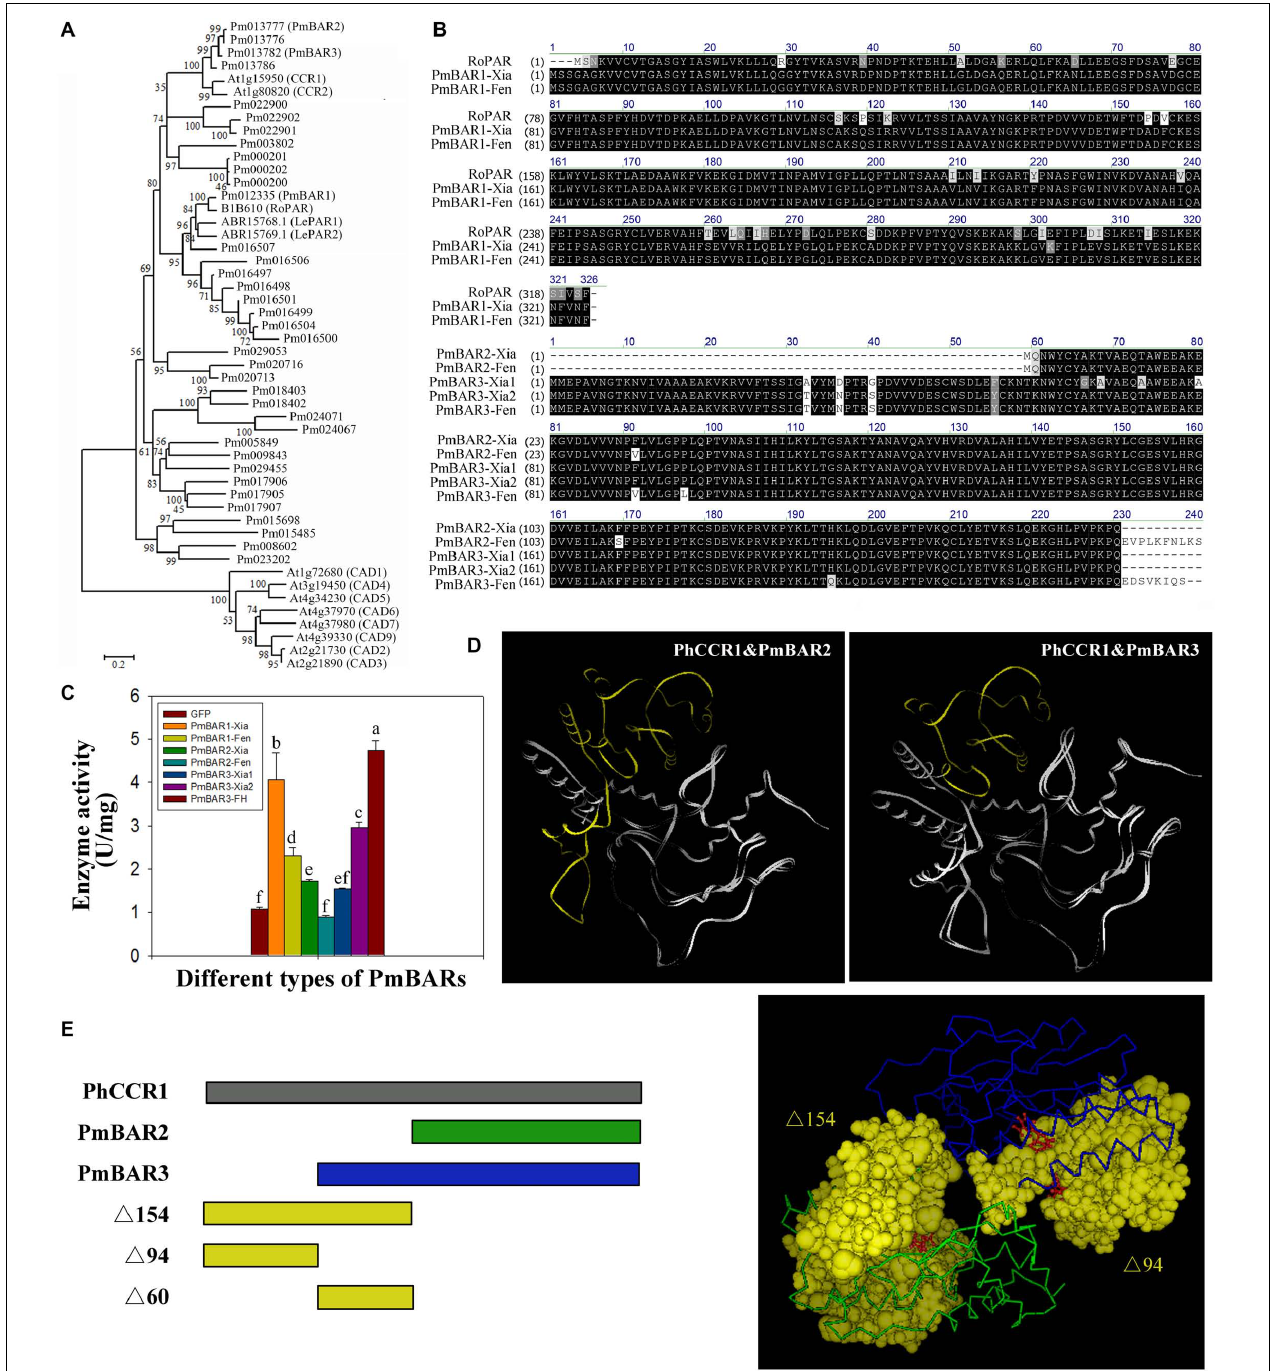
FIGURE 6 | Comparison of the sequences and enzyme activity of PmBARs from the different varieties. (A) Comparison of the PmBAR amino acid sequence in the “Xiangruibai” and “Fenghou” varieties. RoPAR, PAR in rose. RoPAR was used as a reference sequence to identify PmBARs in P. mume . (B) Phylogenetic tree of PmBARs, PARs, CCRs and CADs. The tree was generated using MEGA 6 software with the neighbor-joining method. The bootstrap values (%) are shown next to the branches. The branch lengths were determined by the evolutionary distance. (C) Enzyme activity of PmBARs from the “Xiangruibai” and “Fenghou” varieties. The data are presented as the mean values of three biological replicates ± SDs. The data are presented as the mean values of three replicates ± SDs. A sample expressing GFP was used as a negative control. (D) Comparison of protein tertiary structures between PhCCR1 and PmBARs. The underlying N-terminal deletion sequences PmBARs compared with PhCCR1 are marked in yellow. PhCCR1, CCR1 in petunia. (E) Model of NADP + binding to the N-terminus of PhCCR1 (PDB ID: 4R1S). Schematic diagram of the protein structures of PmBARs and PhCCR1 (left), in which different colors reflect the different segments marked in the tertiary structure (right). NADP + is shown in red and in a ball-and-stick